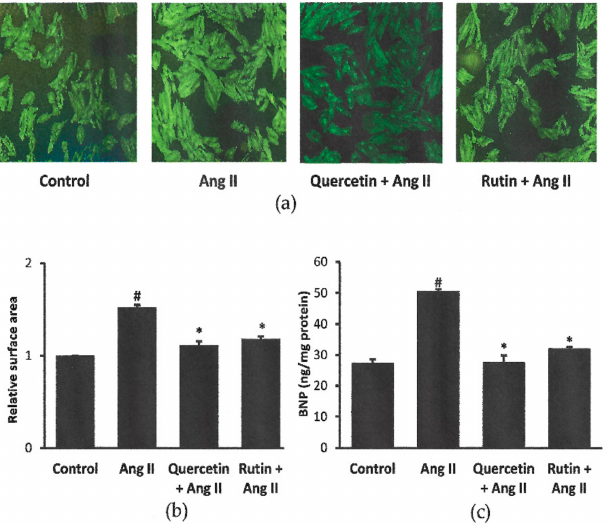
Figure 2. Effects of quercetin (331 µ M) and rutin (50 µ M) on H9c2 cell size shown by ( a ) representative immunofluorescent staining (magnification × 100), ( b ) cell surface area and ( c ) cellular BNP level after 24 h co-treatment with Ang II (600 nM). # p < 0.05 vs. control group, * p < 0.05 vs. Ang II group. Data were analyzed by a one-way ANOVA followed by a Tukey post hoc test and are represented as the mean ± SEM ( n =